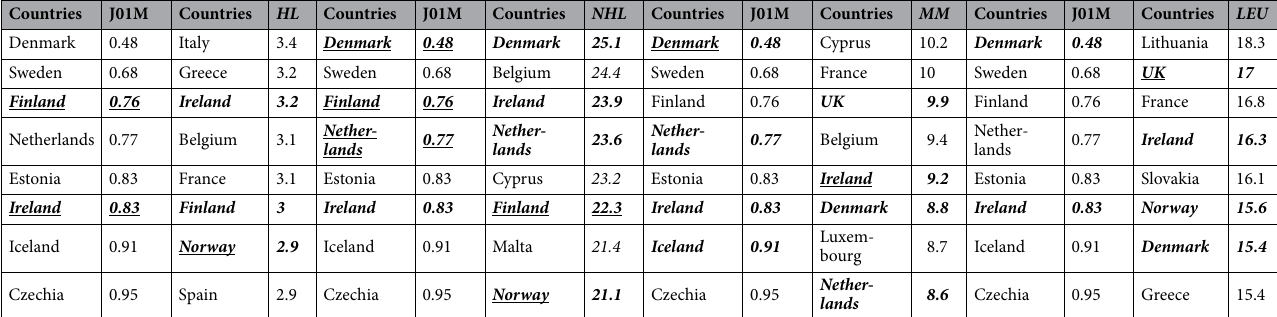
Table 2. Decreasing rank order of “enhancer” antibiotic consumption (J01A, J01CF, J01C) compared to the decreasing rank order of hematological malignancies (HL, NHL, MM, LEU) by countries (first ten positions). A higher overlap between the rank orders is possible indicating that the higher consumption of those antibiotics is associated with the higher incidence rate of hematological malignancies in the given countries. Similarly, the less consumption of the “inhibitory” antibiotics (J01D, J01M) seems to be associated with the higher incidence rate of hematological malignancies. Identical countries were written in bold, italics, and underlined . Concordance was considered, when six, out of the ten countries were identified in the rank order of hematological malignancies and antibiotic